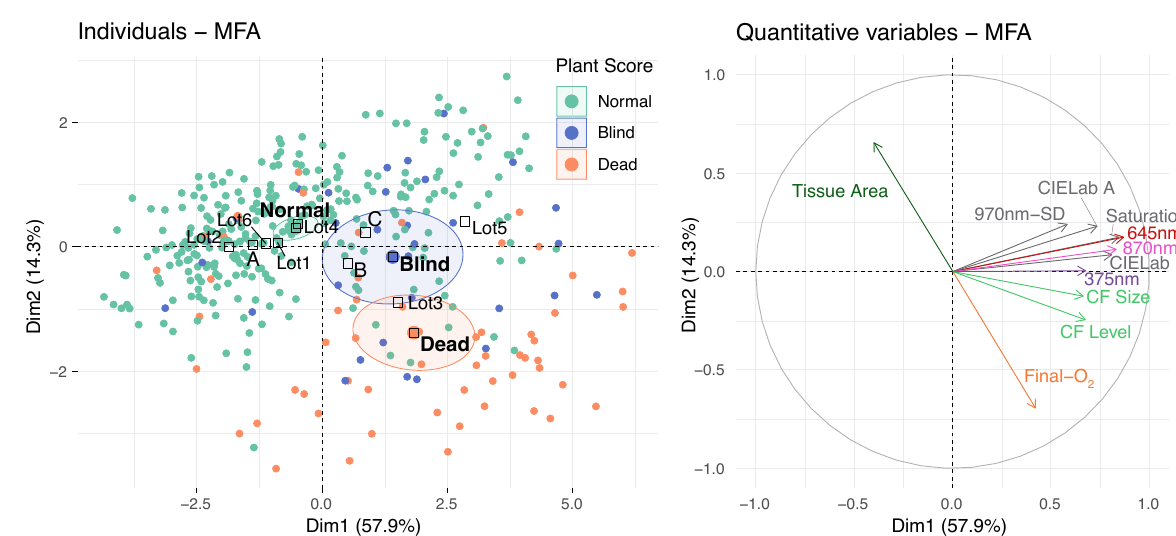
Figure 12. Multiple Factor Analysis (MFA) of features obtained from imaging, respiration and plant growth observations of kohlrabi seeds after blindness induction treatment. ( Left ): Scatter plot of individual seeds identified as normal, blind or dead separated in two dimensions (Dim1 and Dim2) according to their analytical features. Ellipses define confidence areas (95%) for each plant score, while squares represent their corresponding centers of gravity. Additional supplementary qualitative variables for seed variety (A, B or C) and lots (1 to 6) are shown in black. ( Right ): Vector representation of the influence of different measured factors in relation to their contribution to the two principal dimensions. Only complete observations for all parameters shown were used to generate the